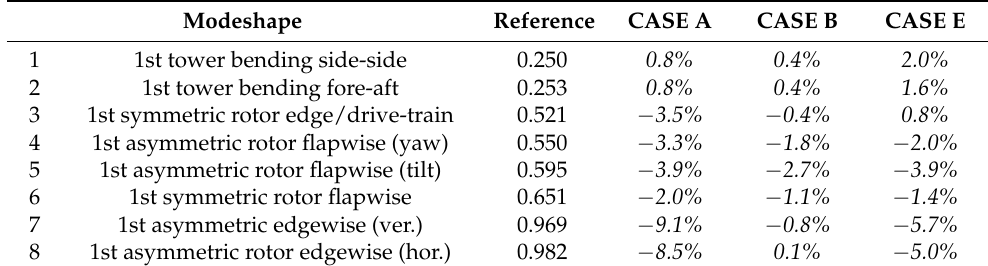
Table 4. Standstill natural frequencies of the reference DTU-10MW RWT and FEC designs. Relative percentage differences with respect to the reference configuration are also provided. Modeshape Reference CASE A CASE